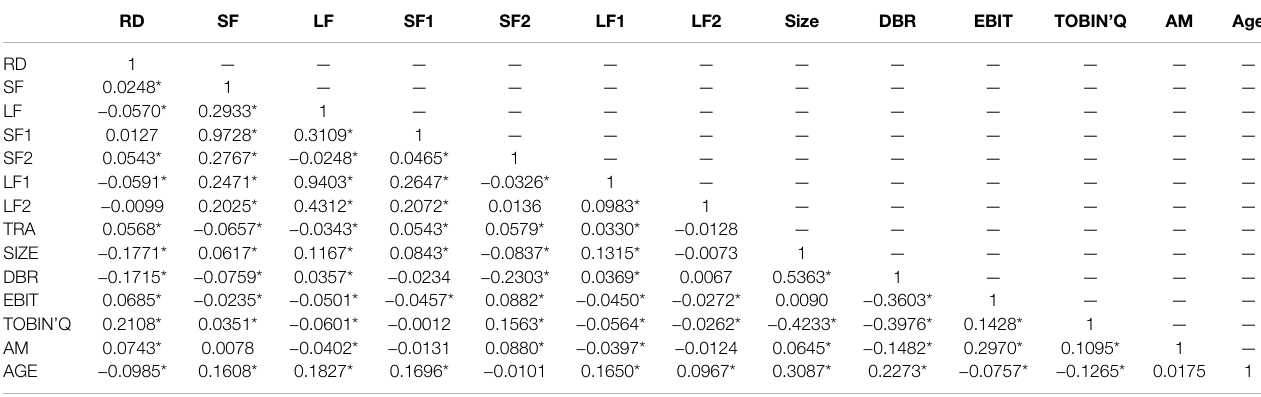
TABLE 3 | Pearson correlation coef fi cient matrix of main